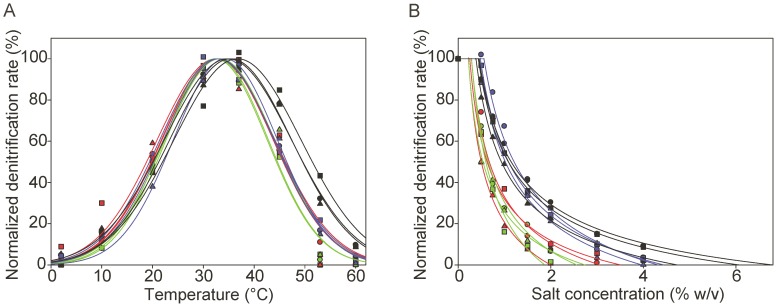
Normalized denitrification rates at different temperatures and salt concentrations.The rates are normalized by percent of the maximum rate within each soil community replicate and modeled using a Gaussian function and a power equation for temperature (a) and salt concentration (b) gradients, respectively. The fitted curves and data points are colored by community and soil treatment: Red, community A, fallow; Green, community B, unfertilized; Blue, community C, nitrate fertilized; and Black, community J, cattle manure fertilized. Each field replicate within a treatment/community is represented by different symbols.